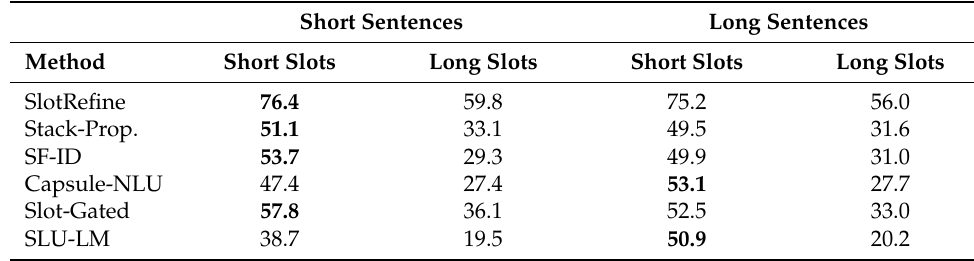
Table 4. Results for slot filling with joint NLU (in %).